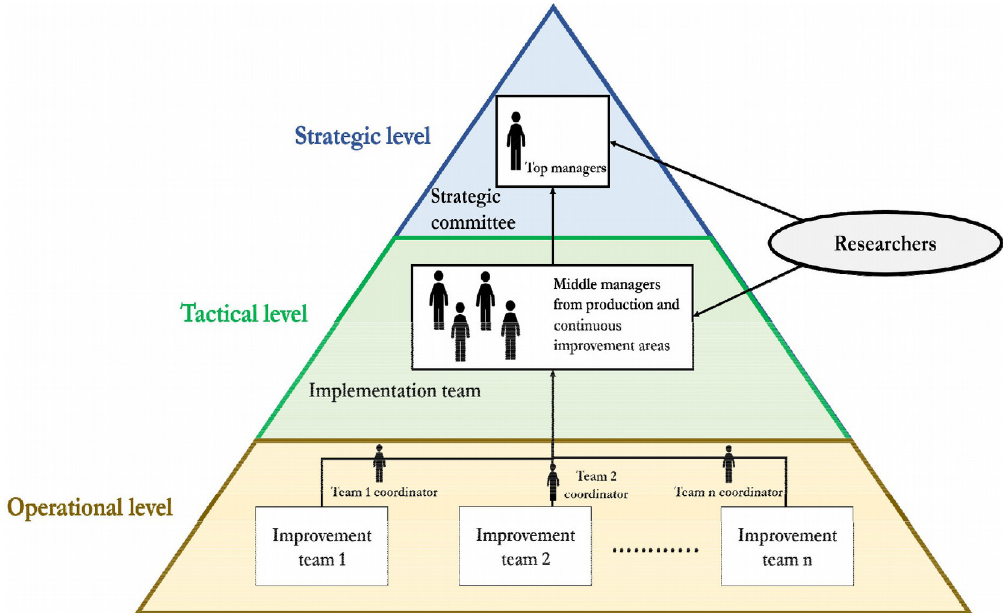
Figure 3. Proposed organizational